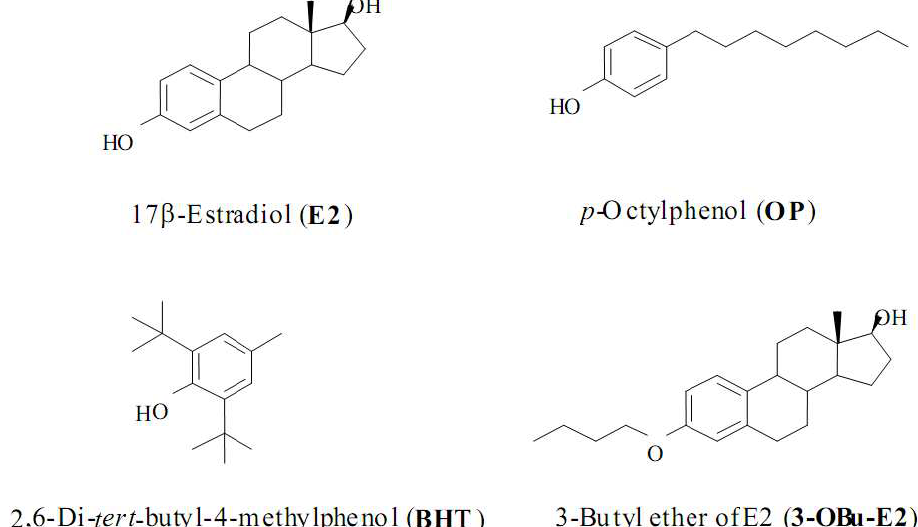
Figure 2. Schematic illustration of how estrogens provide a “chemical shield” from •OH exposure by an antioxidant cycle discovered by Prokai [54,55]. E2 captures •OH